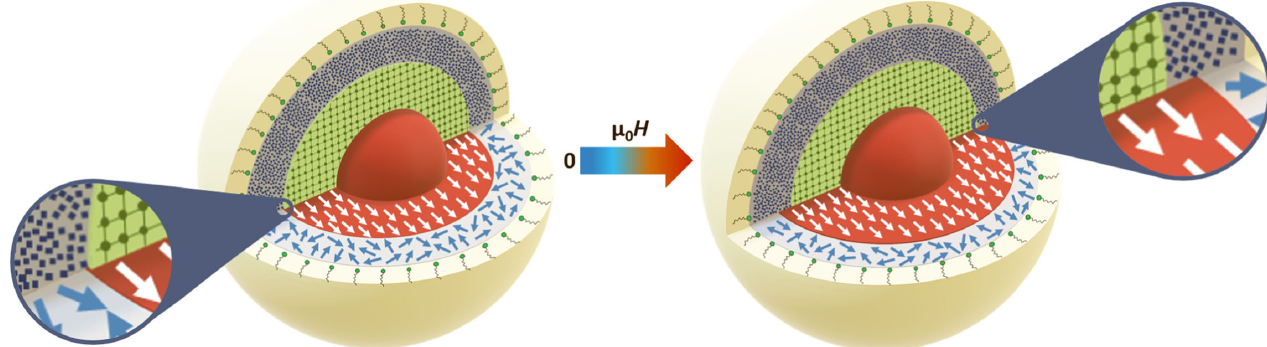
FIG. 1. Schematic of the structural and field-dependent magnetic NP morphology: The vertical cuts represent the structural morphology, consisting of a structurally coherent grain size (green) and structural disorder (blue) within the inorganic particle (gray). The horizontal cuts represent the magnetic morphology, consisting of a collinear magnetic core (red) and spin disorder (blue) within the inorganic particle surface layer (gray). The particle is surrounded by an oleic acid ligand layer (beige). Structural and magnetic particle sizes are equal in zero field (left), whereas the initially disordered surface spins are gradually polarized in the applied magnetic field such that the magnetic radius increases beyond the structurally disordered surface region